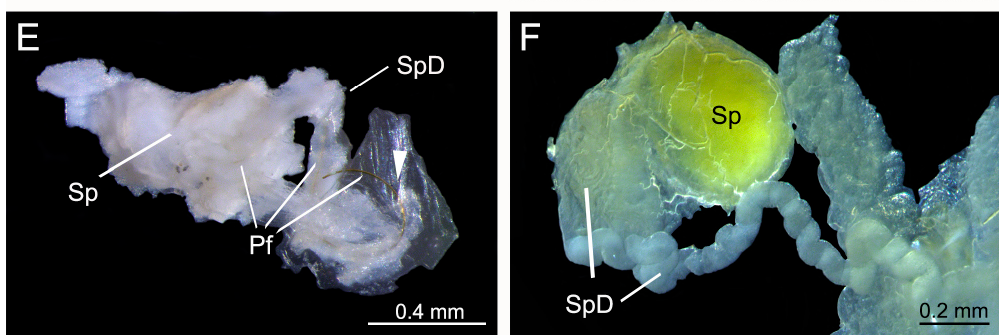
Figure 2. Female genitalia of Terrobittacus implicatus. ( A − C ) and ( E − F ) are auto ‐ montage micrographs.